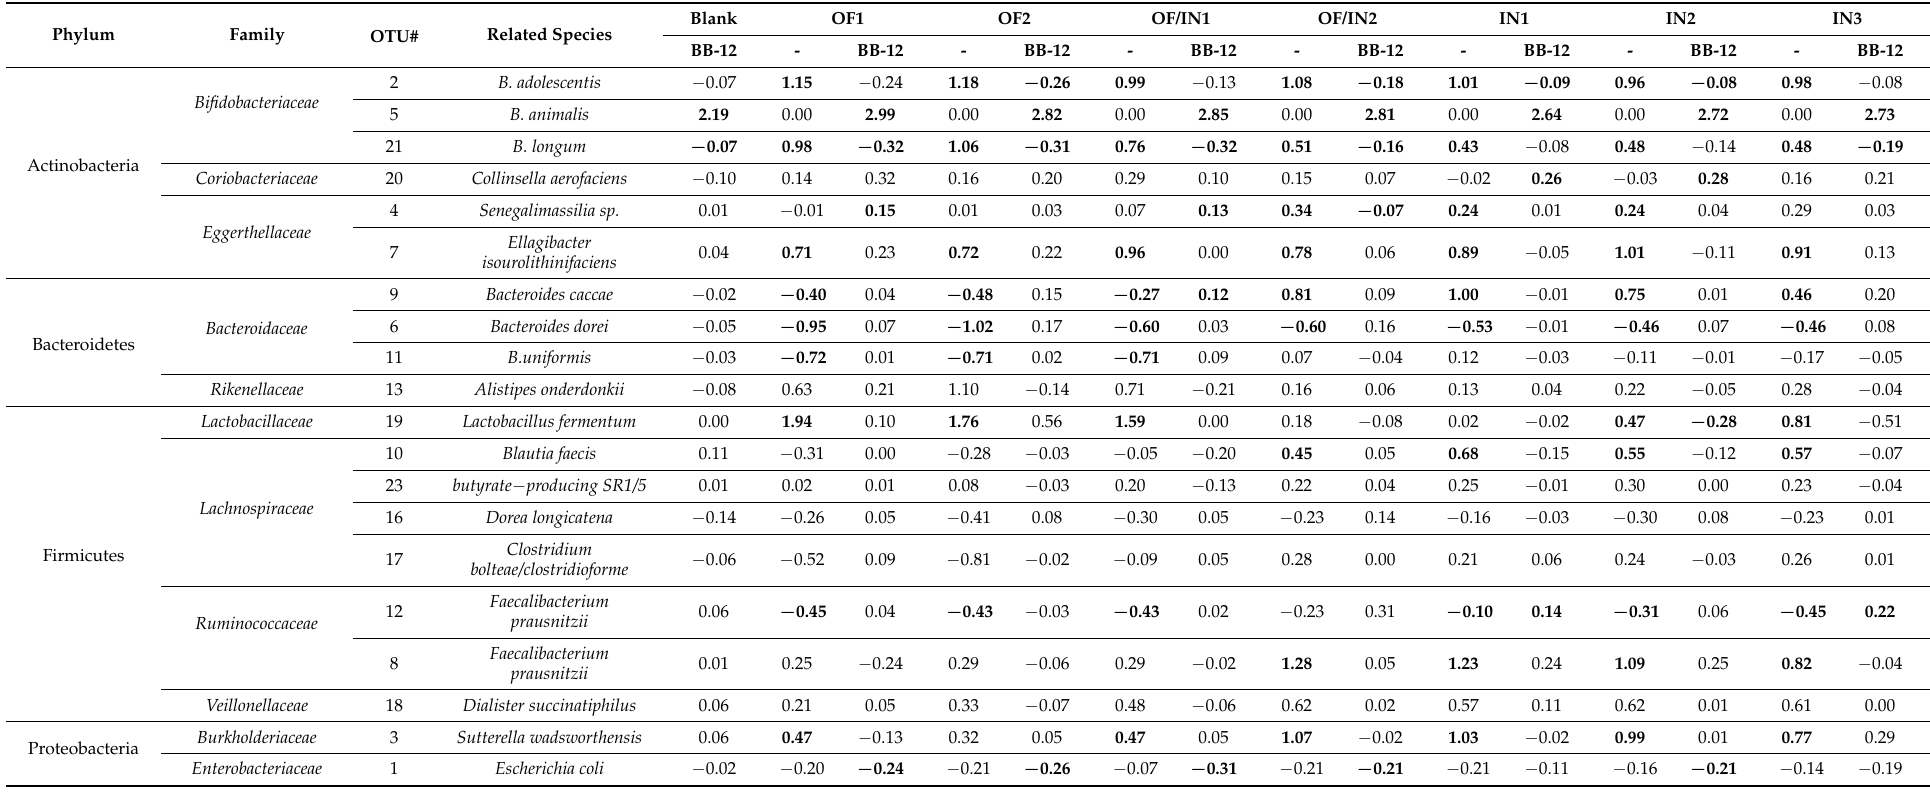
Table 5. Changes of microbial abundances at OTU level (log(cells/mL)) as detected via quantitative 16S-targeted Illumina sequencing at the end of the colonic incubation (48 h) upon dosing BB-12 and/or seven fructans with short (OF1, OF2), intermediate (OF/IN1, OF/IN2) and high degree of polymerization (IN1, IN2 and IN3) to the complex microbiota of three human donors (C, D and F). The values represent average differences versus the respective reference (for fructans, the reference was the untreated blank, while for conditions with BB-12 addition this was the respective condition where BB-12 was not dosed) at the end of the colonic incubation over the three donors. For optimal visualization, increases due to treatment are highlighted with grey shading, with significant changes being indicated in bold ( n = 9; 3 values for each of the 3